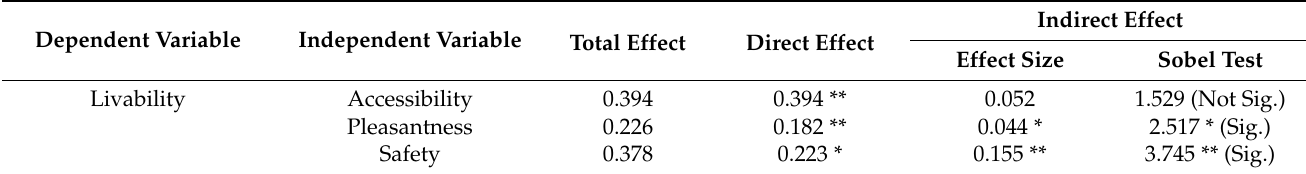
Table 5. Direct effect, indirect effect, and total